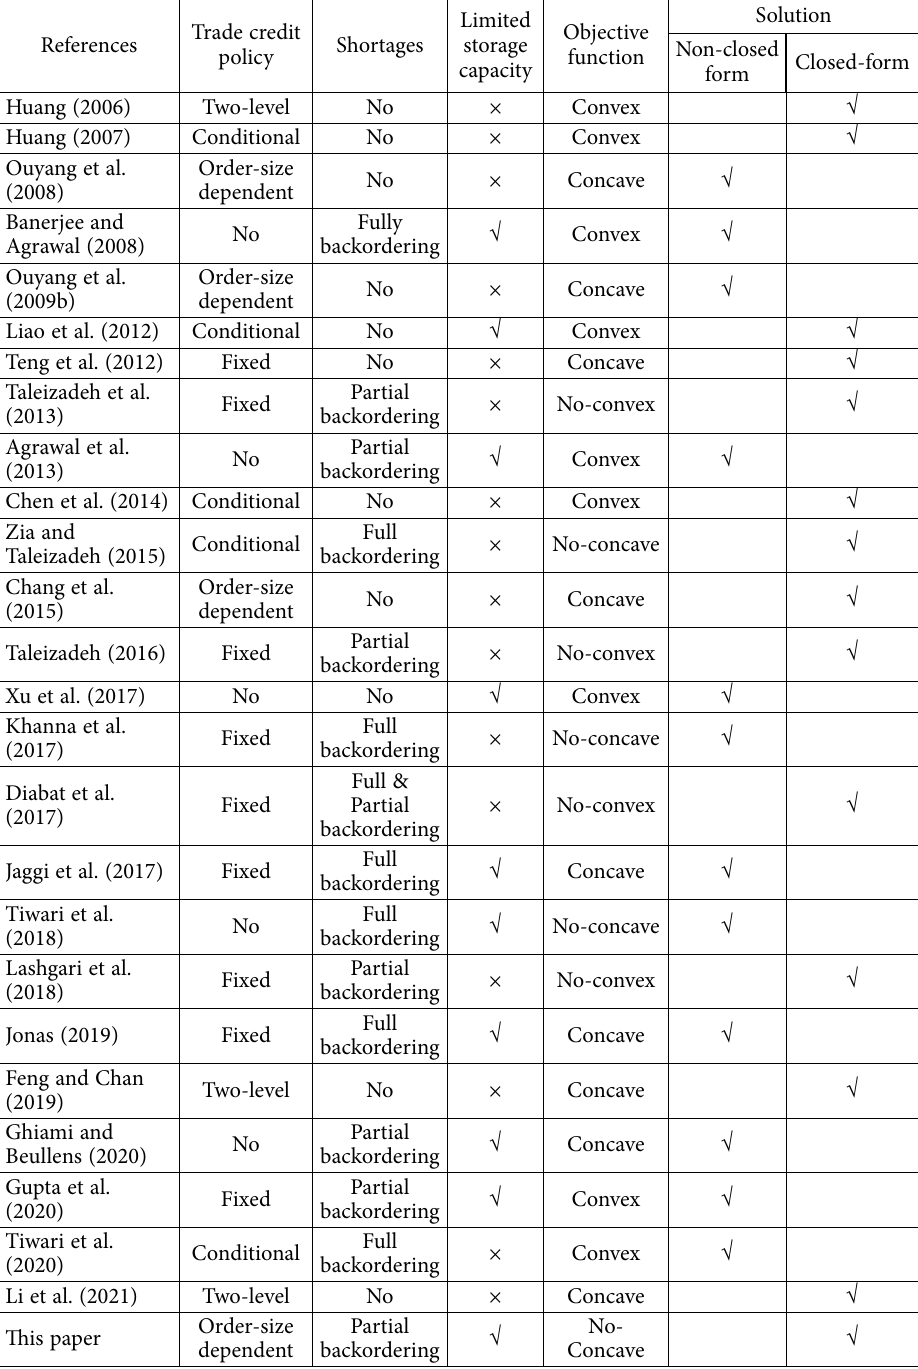
Table 1. A brief comparison between earlier published literature and our